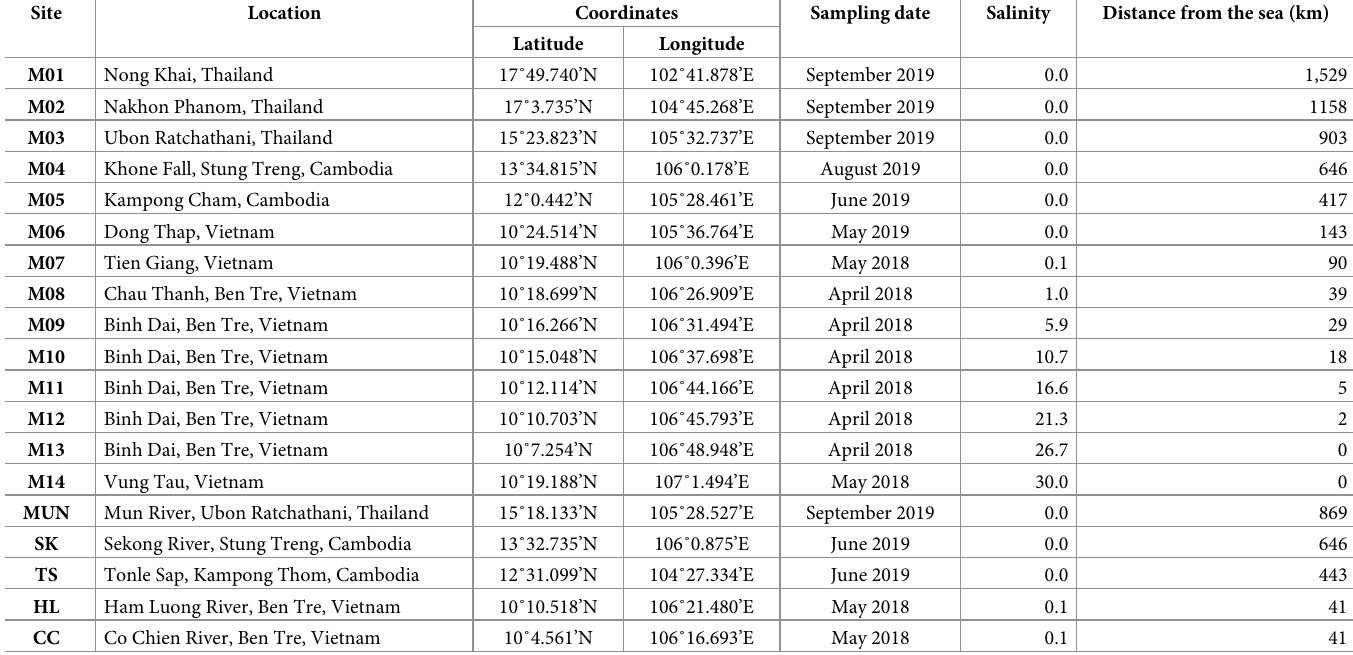
Table 1. Water samples collected along the Mekong River and its